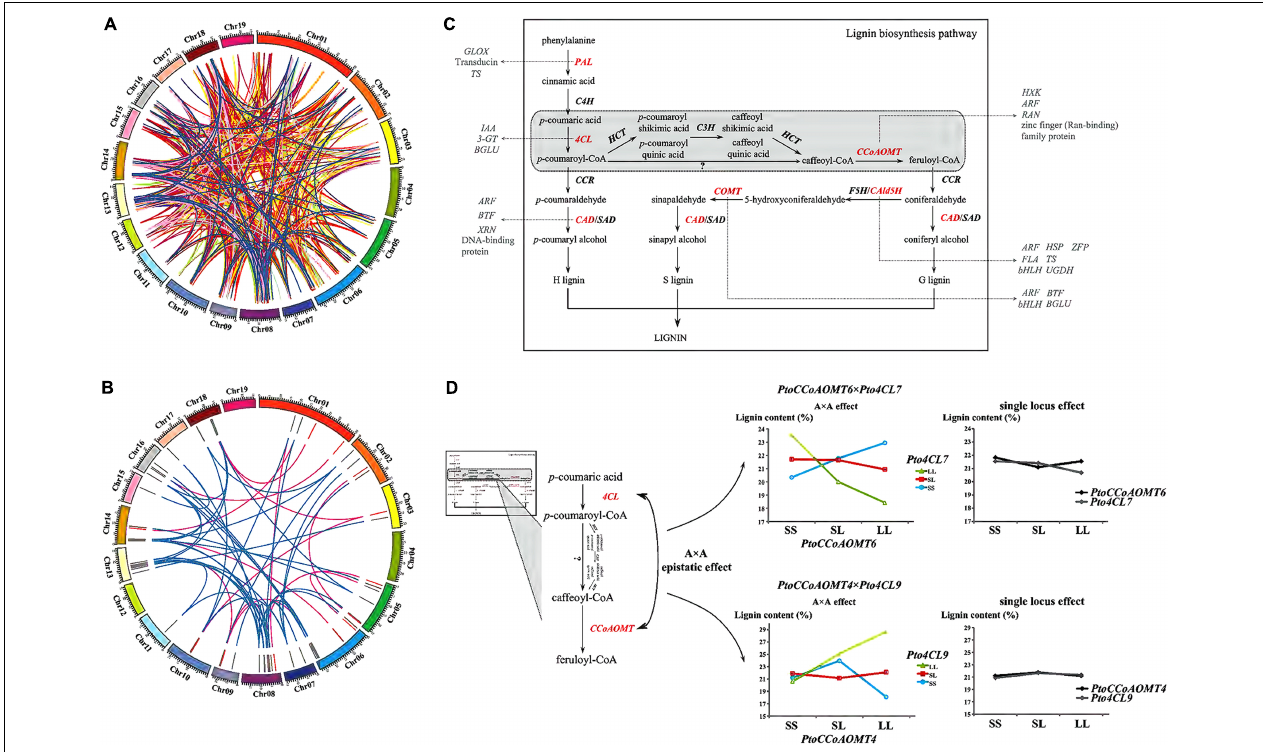
FIGURE 5 | Dissection of the gene–gene epistatic interaction networks for 10 growth and wood-property traits. (A) Circular diagram depicting 973 gene–gene interaction networks for 10 growth and wood-property traits. The different colored links represent different traits. Detailed information for each trait was showed in Supplementary Figure S3 . (B) Circular diagram depicting the 55 epistatic gene–gene interaction networks underlying lignin contents. The outer track showed the P. Tomentosa chromosomes (Chr01 through Chr19 on an Mb scale). The middle track showed the epistatic genes involved in the monolignol biosynthesis pathway (red) or in other pathways (gray). The inner links showed the epistatic interactions between genes where at least one gene belonged to the monolignol biosynthesis pathway (pink), or neither belonged (blue). (C) Proposed pathway of lignin biosynthesis. The genes that had epistatic effects involved in the lignin biosynthesis pathway (red), and the putative genes and epistatic interactions that contributed to the proposed monolignol biosynthesis pathway revealed in our study (gray) were shown. (D) Dissection of two epistatic gene–gene interactions underlying the monolignol biosynthesis pathway with A × A epistatic effects. PAL, phenylalanine ammonia-lyase; C4H, cinnamate-4-hydroxylase; 4CL, 4-coumarate:CoA ligase; CCR, cinnamoyl-CoA reductase; CAD, cinnamyl alcohol dehydrogenase; SAD, sinapyl alcohol dehydrogenase; HCT, p -hydroxycinnamoyl-CoA:quinateshikimate p -hydroxycinnamoyltransferase; C3H, 4-coumarate 3-hydroxylase; CCoAOMT, caffeoyl-CoA O -methyltransferase; CAld5H/F5H, coniferyl aldehyde 5-hydroxylase; COMT, caffeic acid/5-hydroxyconiferaldehyde O -methyltransferase; 3-GT, anthocyanidin 3- O -glucosyltransferase; ARF, auxin responsive factor; BGLU, beta glucosidase; BTF, basic transcription factor; FLA, FASCICLIN-like arabinogalactan protein precursor; GLOX, glyoxal oxidase; bHLH, basic helix-loop-helix transcription factor; HSP, heat shock protein; HXK, hexokinase; IAA, indole-3-acetic acid; RAN, RAN GTPase; TS, threonine synthase; UGDH, UDP-glucose dehydrogenase; XRN, exoribonuclease; ZFP, zinc finger